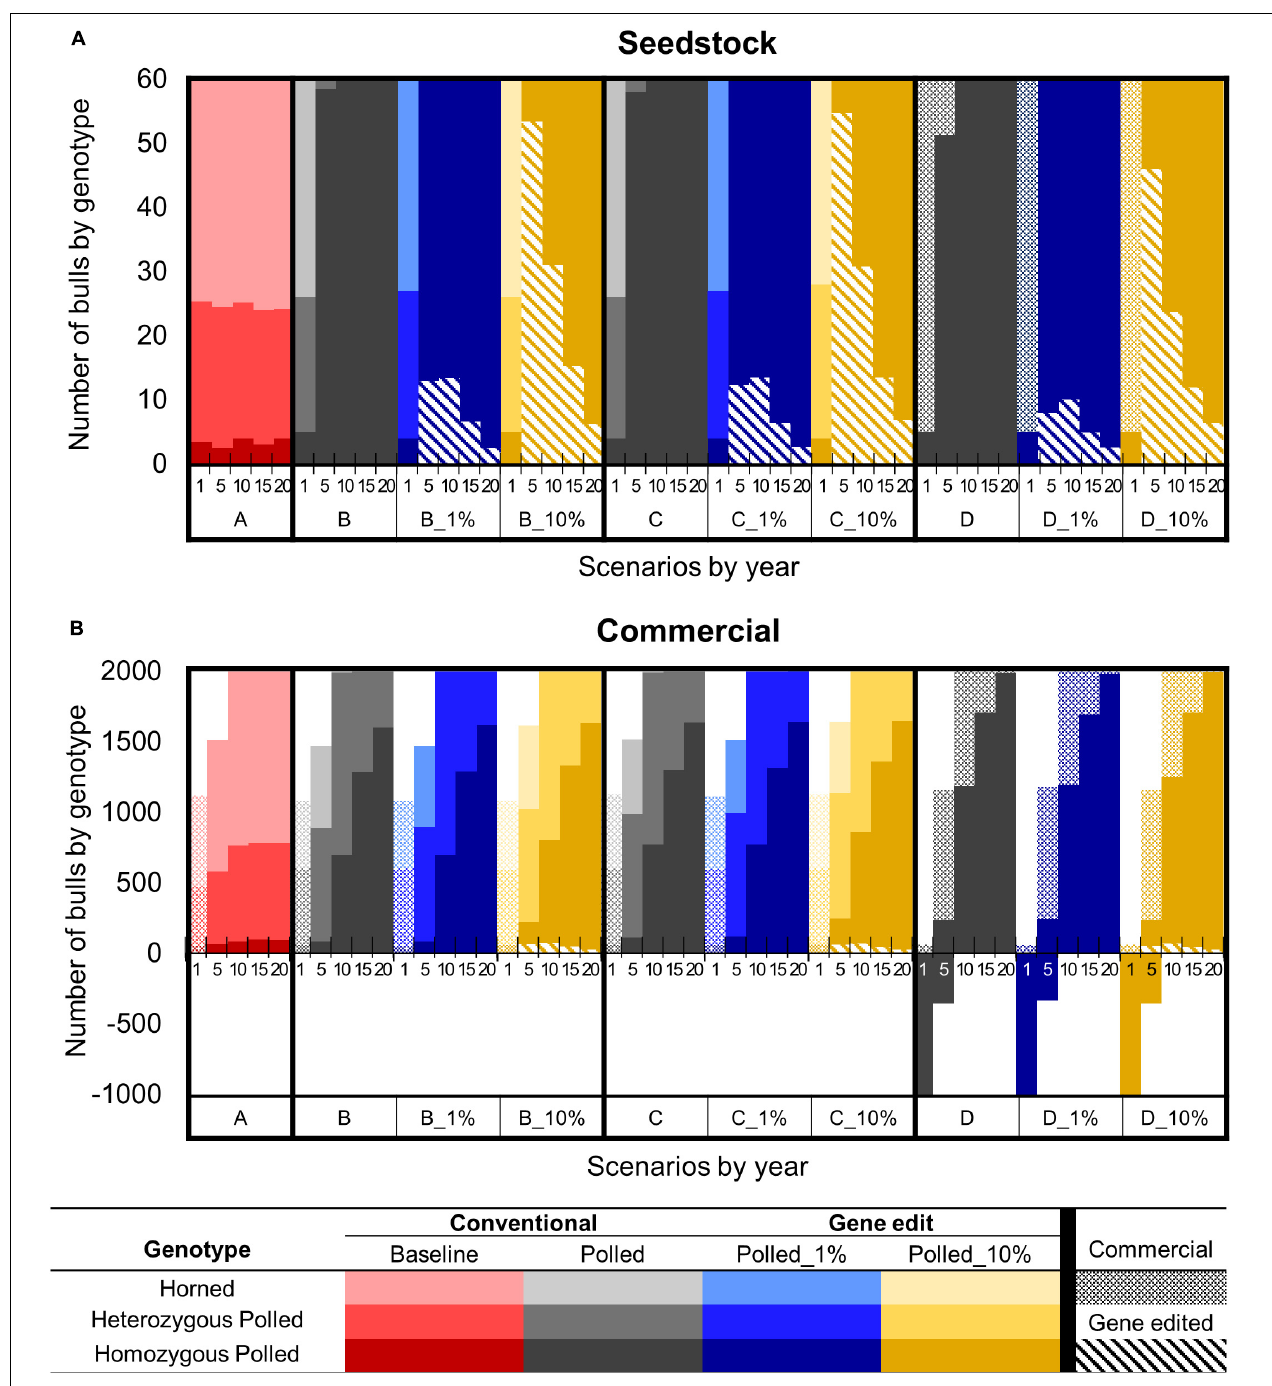
FIGURE 7 | Effect of each scenario on the number of sires used by genotype in year 1, 5, 10, 15, and 20 for the seedstock (A) and commercial (B) populations. Genotypes are represented by a color scale from darkest (homozygous polled) to lightest (horned). Bulls produced via natural mating and sourced from the seedstock or commercial population are represented by solid or dotted bars, respectively. Gene edited seedstock sourced bulls are represented by diagonal hatched bars. Solid bars below the x -axis represent the deficit of bulls necessary to breed all females in the scenario.